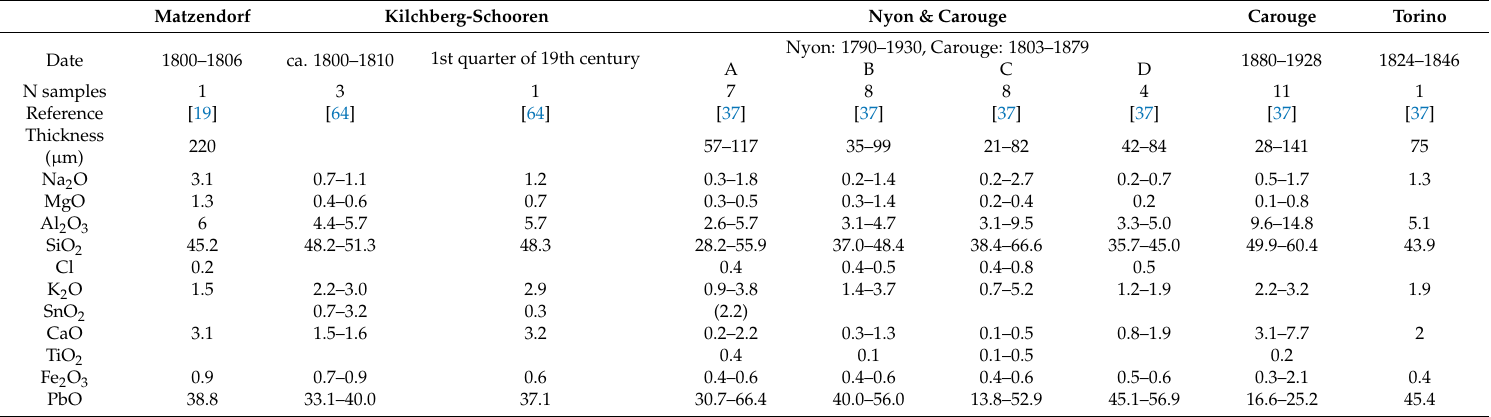
Table 7. Thicknesses and SEM-EDS analyses (wt %) of Swiss and Italian white earthenware